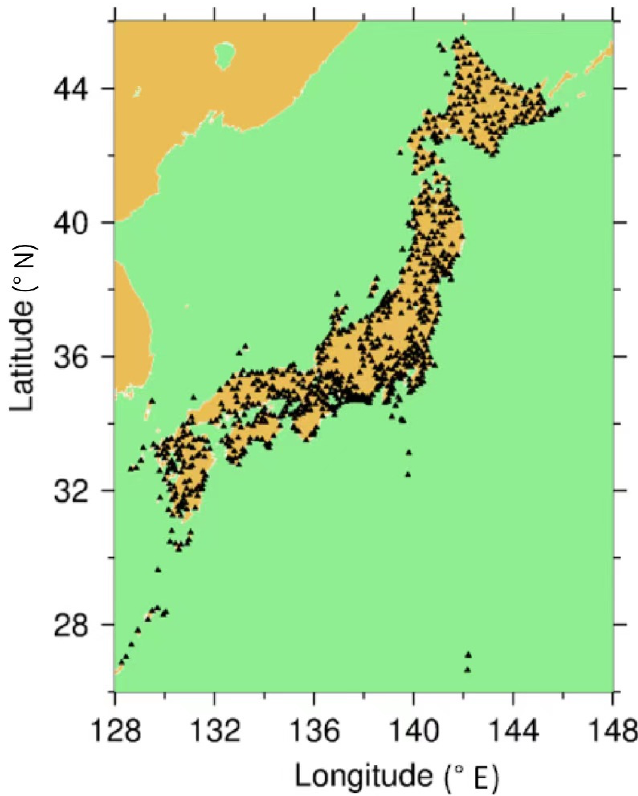
Figure 1. Geographic location of 839 GNSS receivers in GEONET.